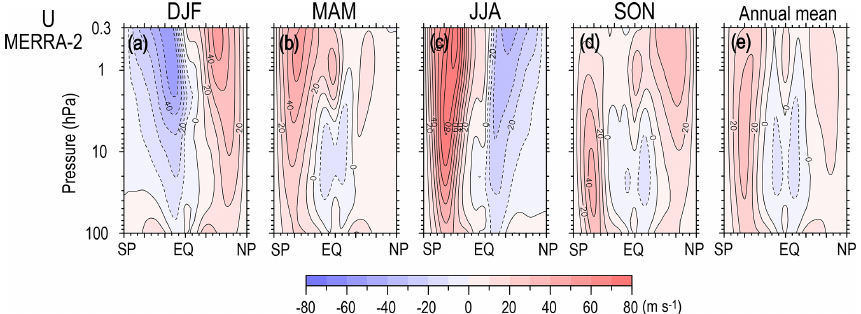
Figure 1. Meridional cross sections for the climatology of seasonal mean zonal mean zonal wind for (a) DJF, (b) MAM, (c) JJA, and (d) SON, and (e) for the annual mean.